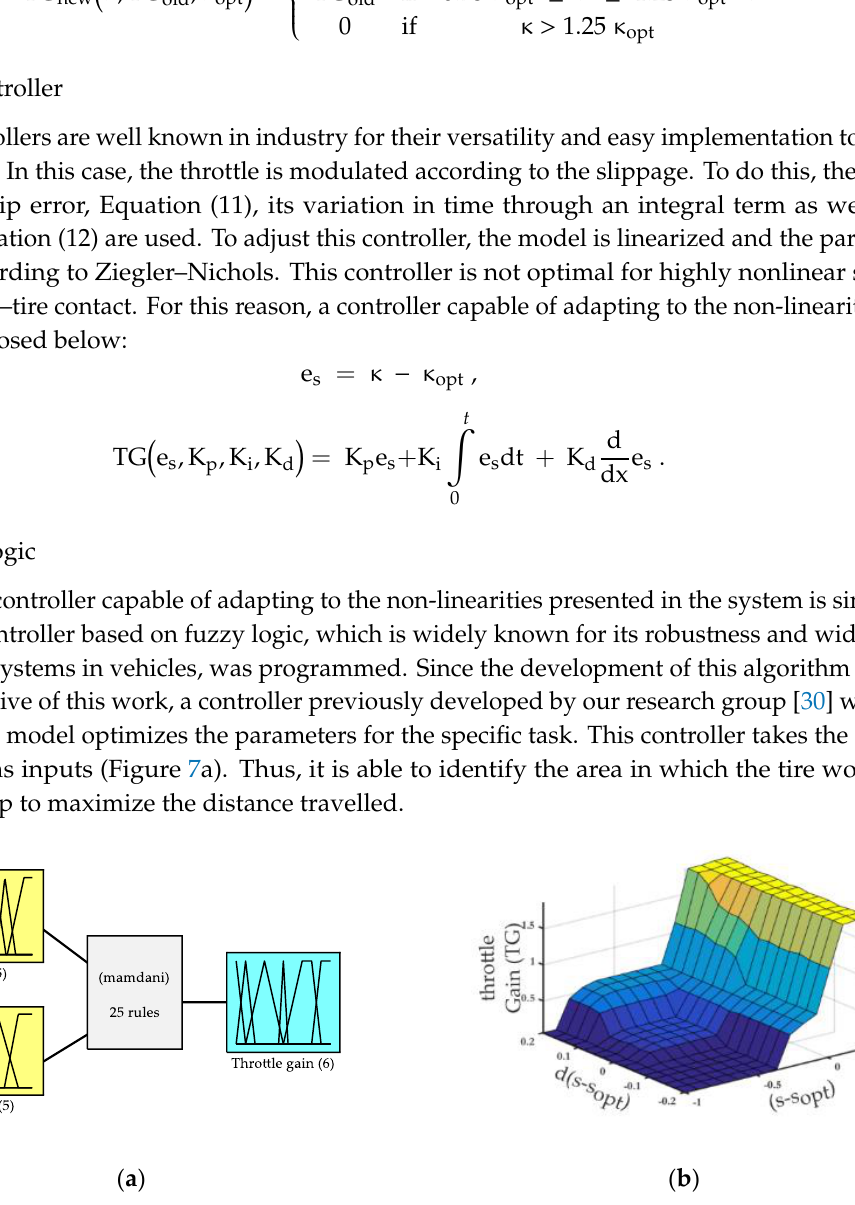
Figure 7. Fuzzy-logic controller: ( a ) membership functions, ( b ) system output surface.